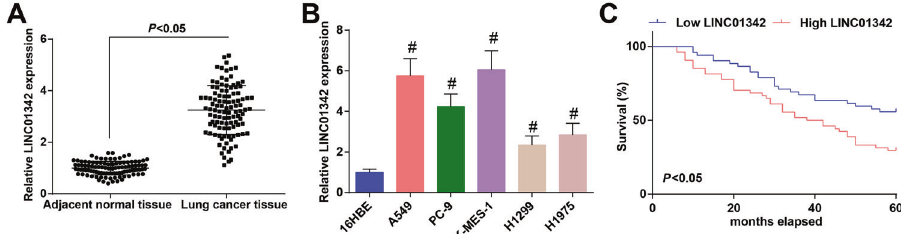
Fig. 1 LINC01342 is upregulated in LC tissues and cells, and the upregulation indicates a poor prognosis of LC patients. A and B LINC01342 expression in clinical samples and cell lines was determined using RT-qPCR. C the prognostic role of LINC01342 in LC patients was detected using Kaplan – Meier analysis; # P < 0.05 vs. 16HBE cells. Table 1. Relationship between LINC01342 expression and clinicopathological characteristics of lung cancer patients.